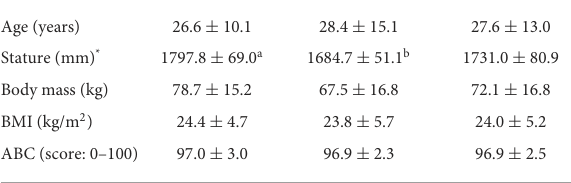
TABLE 1 Participant demographics (mean ± S.D.; n =